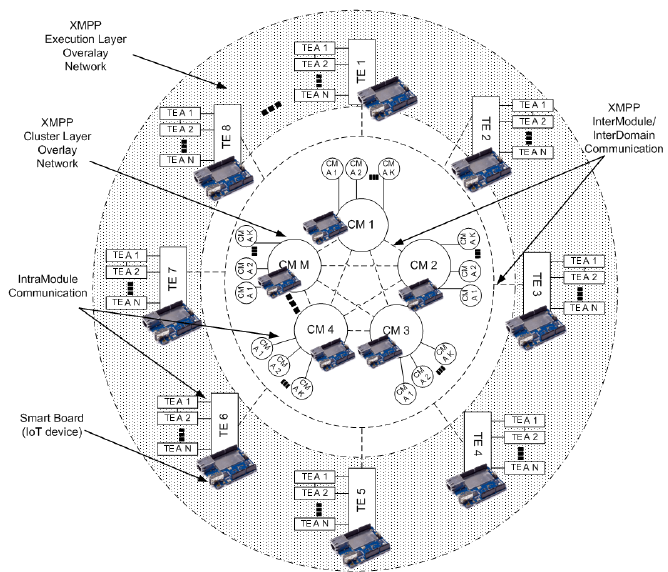
Figure 1. MOM4C scheme adapted for a an IoT scenario.